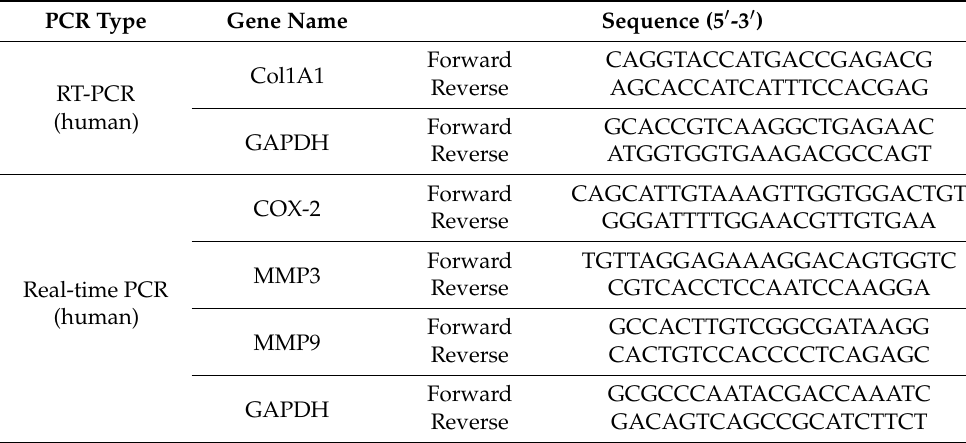
Table 3. Sequences of primers used in